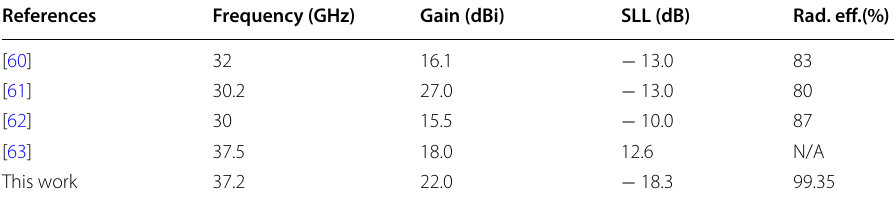
Table 4 Performance comparison of the presented waveguide